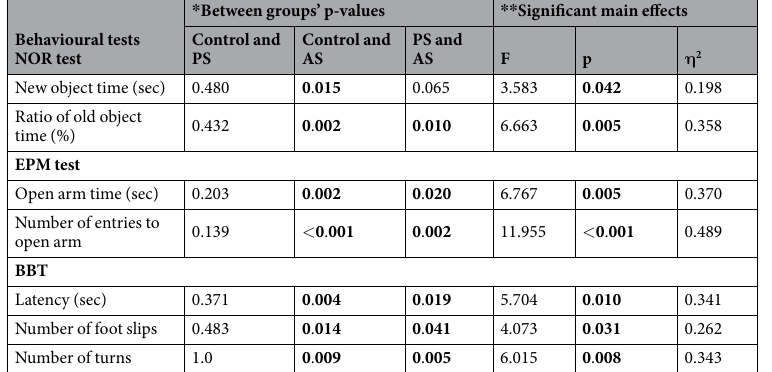
Table 1. Comparison among the three groups in different measures of the three behavioural tests. AS: auditory stress, BBT: balance beam test; EPM: elevated plus maze; NOR: novel object recognition, PS: physical stress, η 2 = estimate of effect size. * The “between groups’ p-values” show p-values for the between group comparisons, and ** “significant main effects” indicate the statistical results of a significant main effect for every measure.